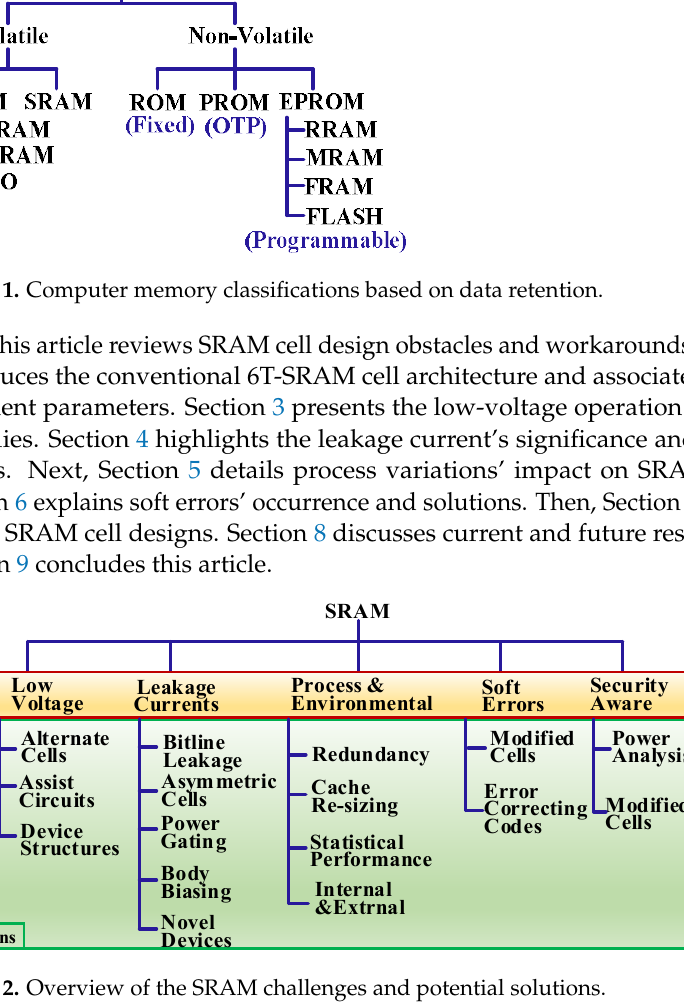
Figure 2. Overview of the SRAM challenges and potential solutions.